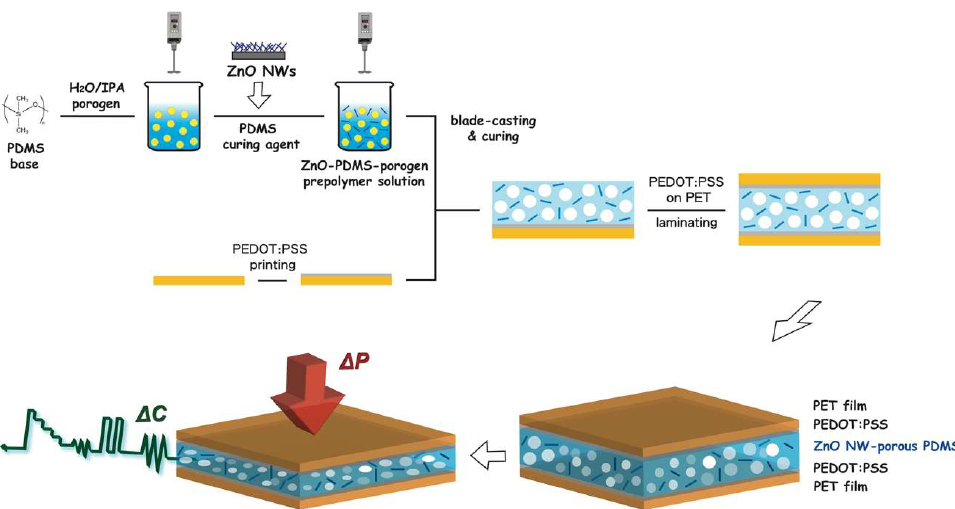
Figure 1. Schematic illustration for fabricating a porous polydimethylsiloxane-based nanocomposite dielectric film hybrid with zinc oxide nanowire for the formation of flexible capacitive pressure sensors.